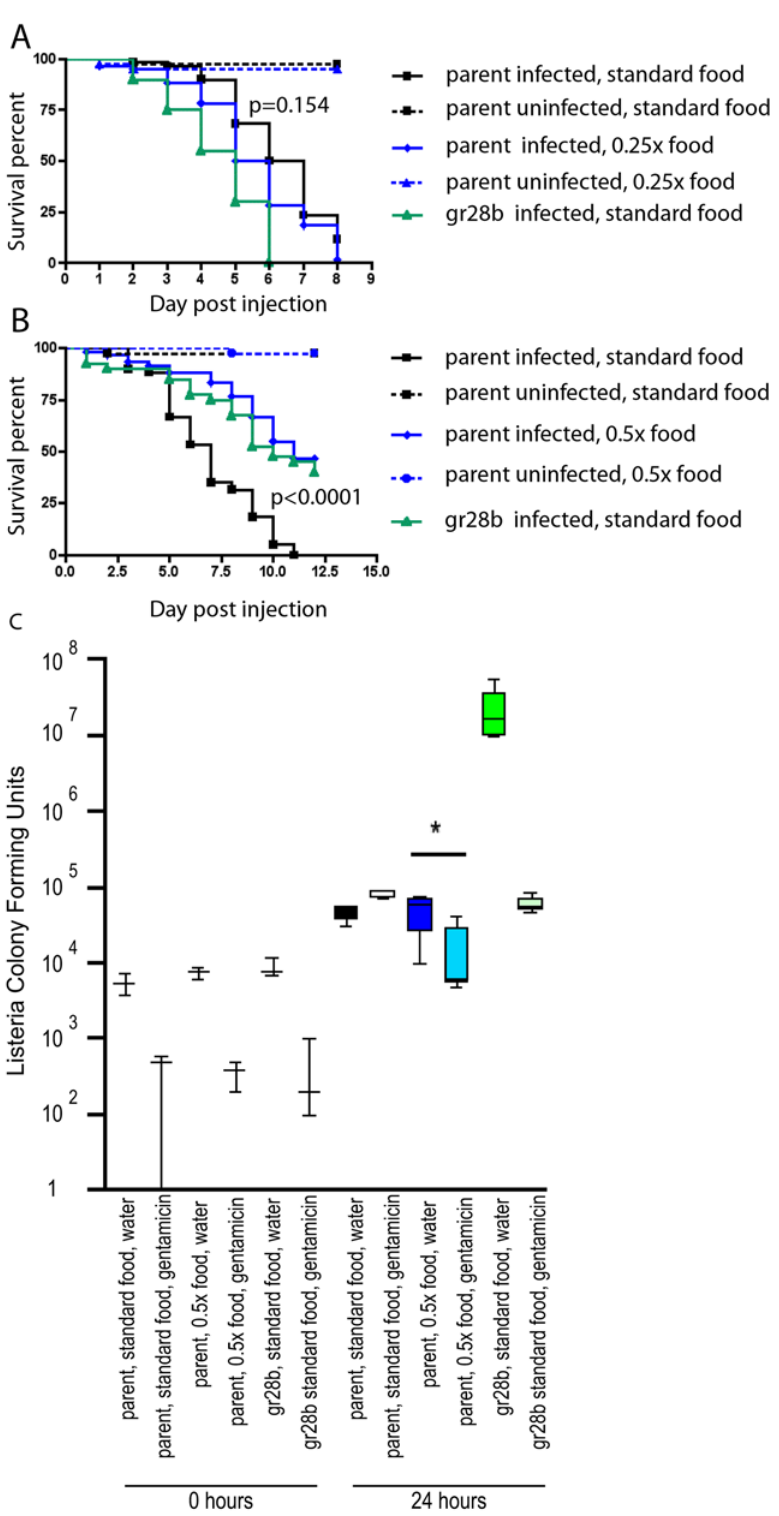
Figure 5. Effects of diet restriction on immunity when introduced post-eclosure. Five to 7-d-old adult males flies were collected and placed on a restricted diet or left at a 1 6 diet 24 h prior to infection. Survival of (A) L. monocytogenes (0.25 6 compared to 1 6 , p =0.0154); (B) S. typhimurium (0.5 6 compared to 1 6 , p , 0.0001); (C) growth of L. monocytogenes . Because L. monocytogenes infections showed a change in pathogen levels, half of the infected flies were injected with gentamicin to determine the relative abundance of intracellular and extracellular bacteria. Asterisk indicates p =0.0173 as determined by an unpaired two-tailed t -test.